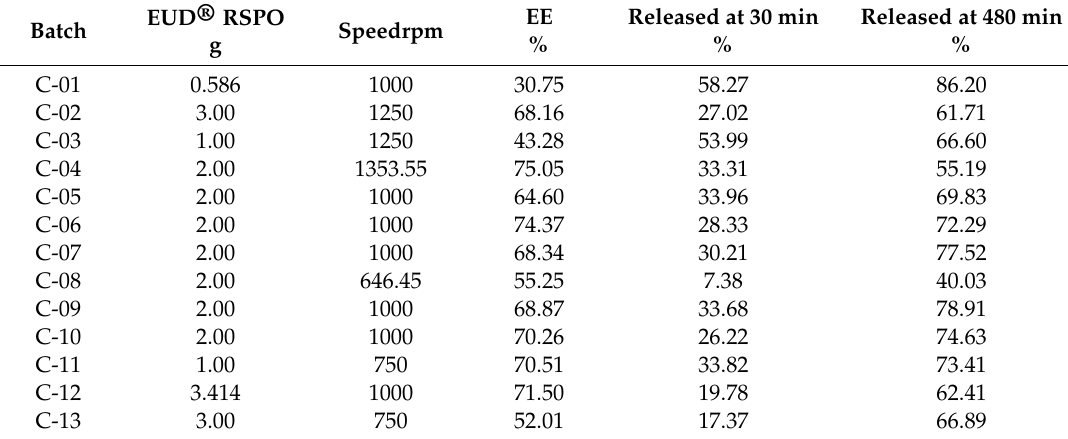
Table 4. Central composite design (CCD) input variables and outputs for the manufacture of CPT